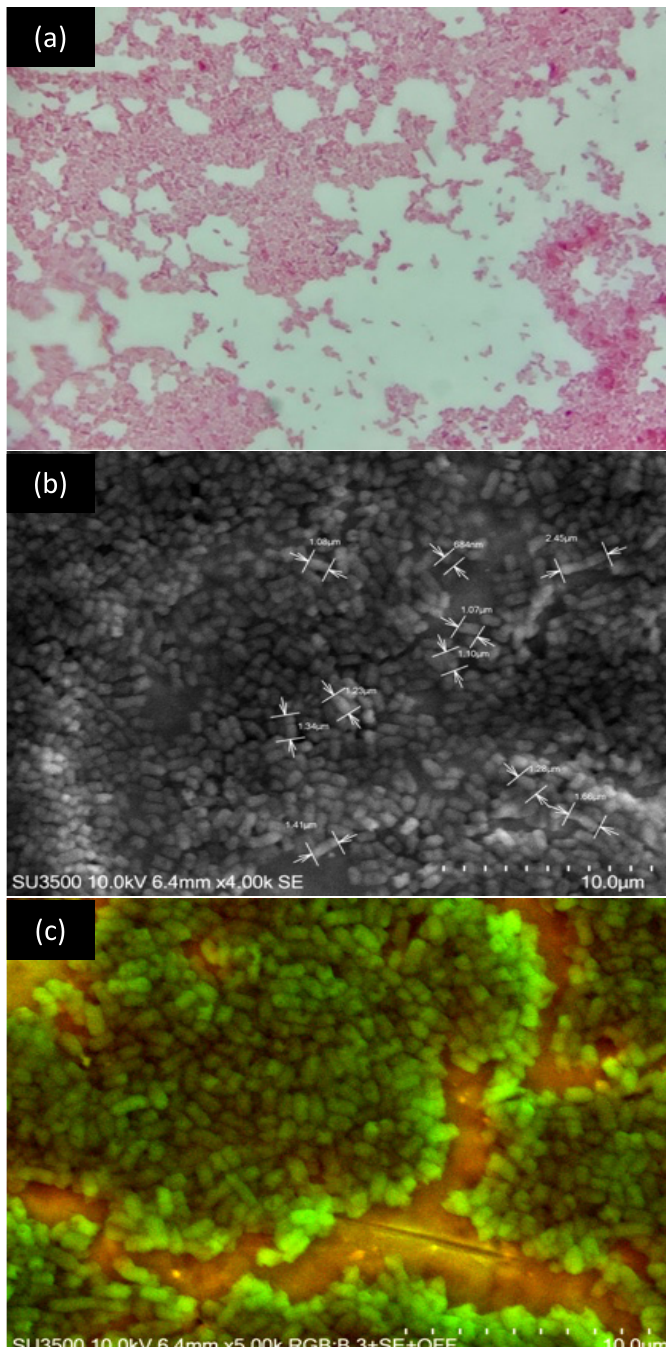
Figure 3. Microscopic visualization of the strain Se8.10.12. ( a ) Gram staining at 100× magnification; ( b , c ) are images obtained by scanning electronic microscopy showing details of size and morphology, respectively.